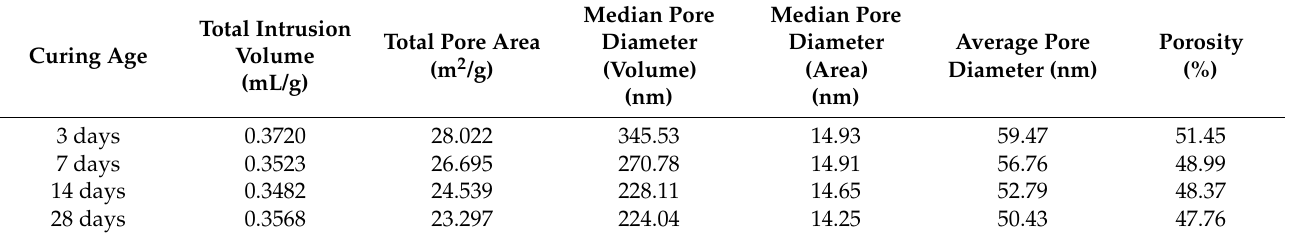
Figure 12. MIP results obtained for specimens at different curing ages: ( a ) total porosity and effective porosity; ( b ) pore size distribution. Table 7. Main pore structure parameters of the tested COSGB